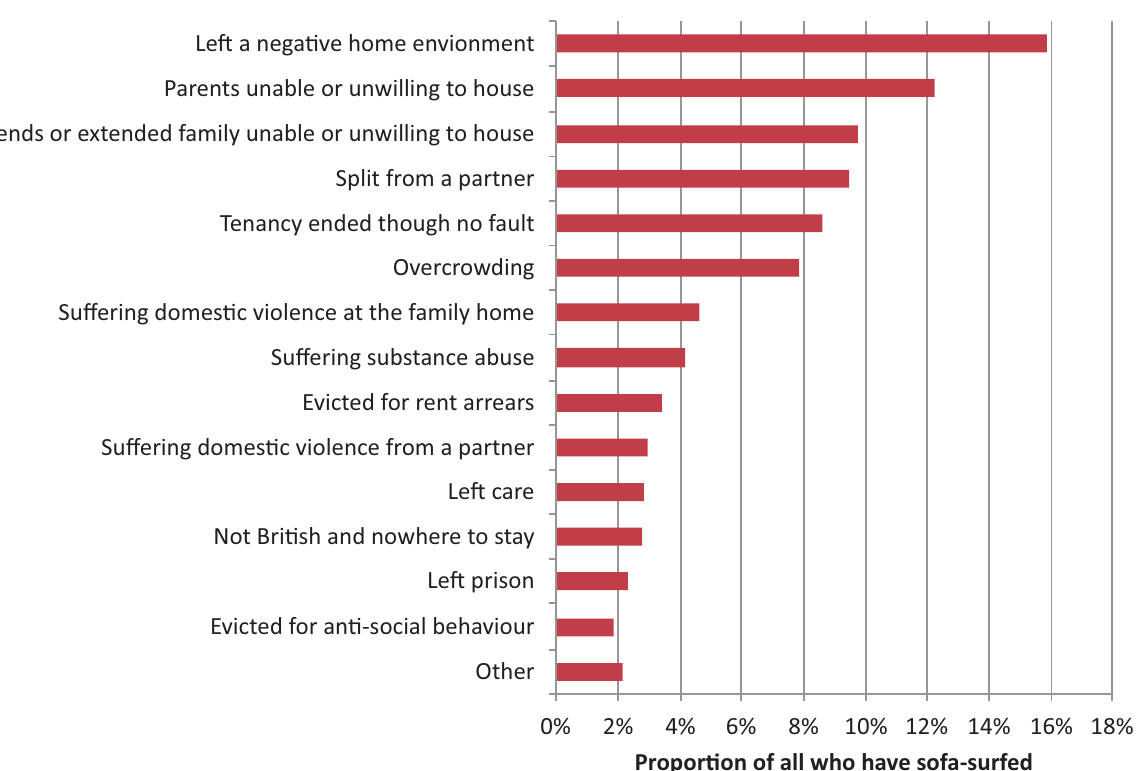
Figure 1. Reasons for sofa surfing among people aged 16–24 identified as sofa surfing in the year to September 2014. Source: Clarke et al. (2015). Respondents could only give one